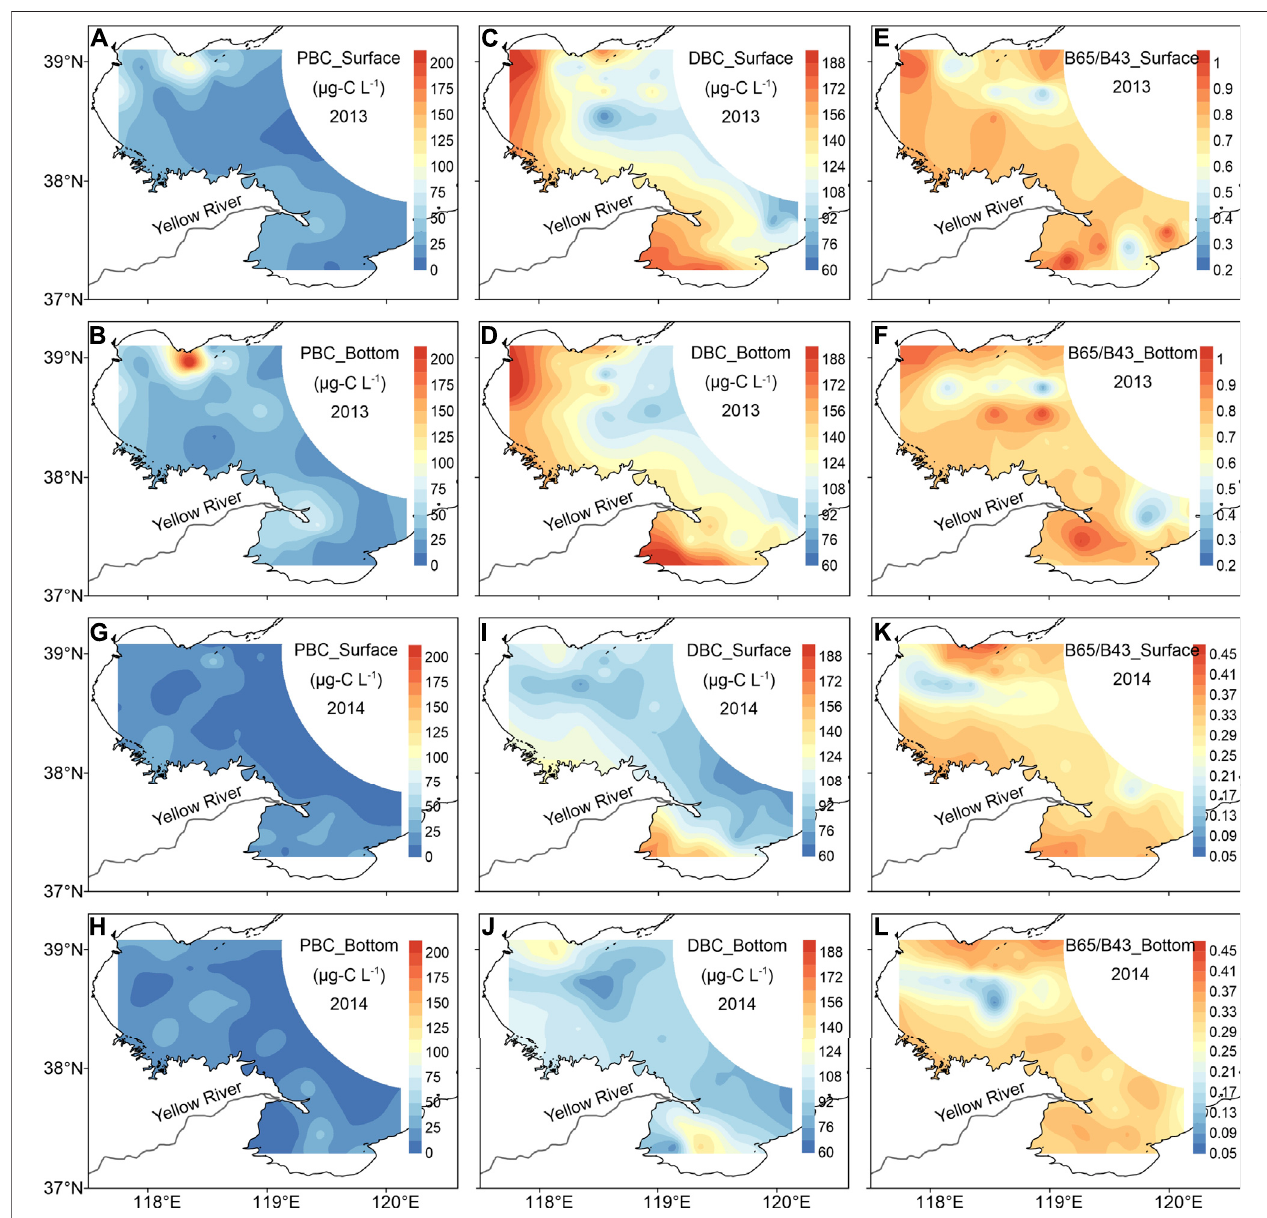
FIGURE 2 | Distributions of PBC and DBC concentrations as well as DBC aromatic condensation in BHB and LZB in 2013 and 2014. Note: 1) Datasets for illustrating Figures 2A – F and Figures 2G – L are referred to Supplementary Table S4 and Fang et al. (2021), respectively; 2) DBC molecularly aromatic condensation was characterized by the ratio of (B6CA + B5CA)/(tB4CA + tB3CA), and we abbreviated it as B65/B43 (tB4CAs and tB3CAs denote total (including nitrated and non- nitrated) B4CAs and B3CAs, respectively, listed in Supplementary Table S2 ).